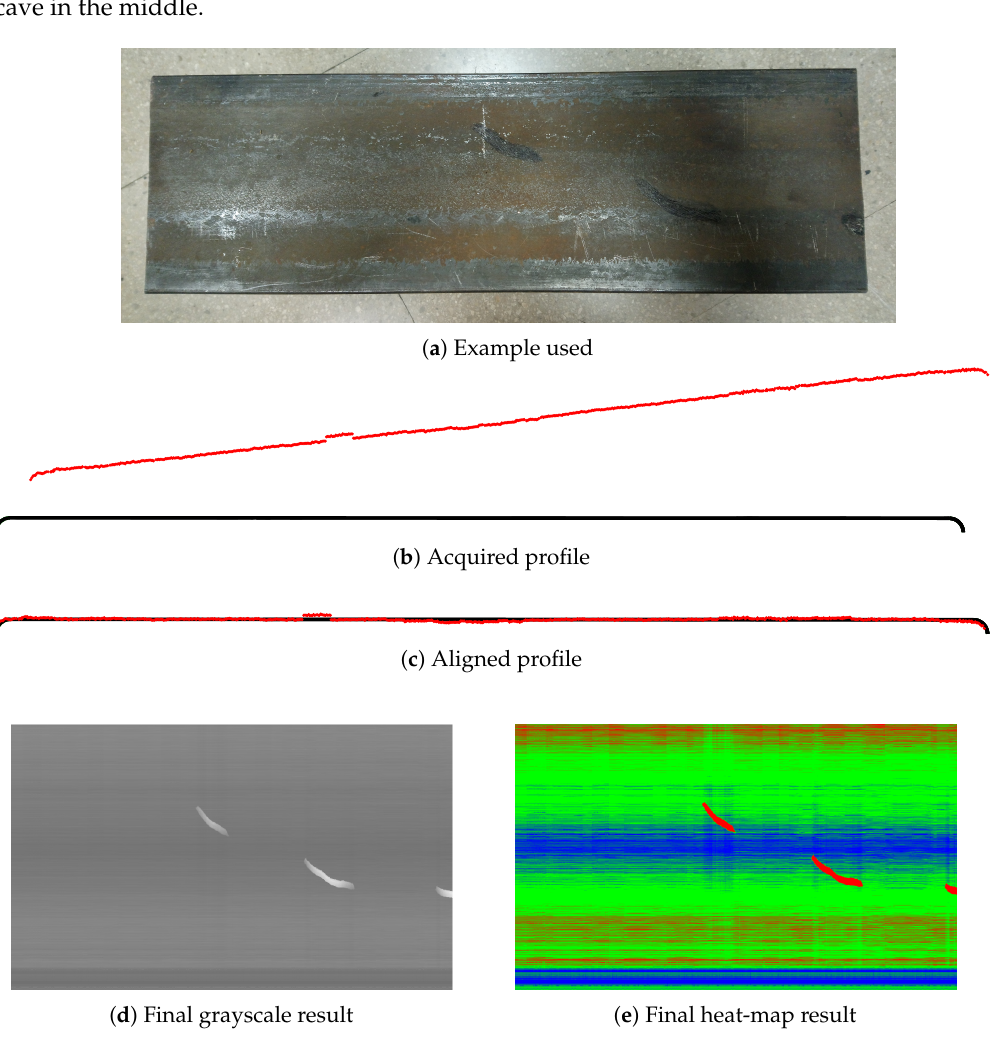
Figure 3. Acquisition and representation